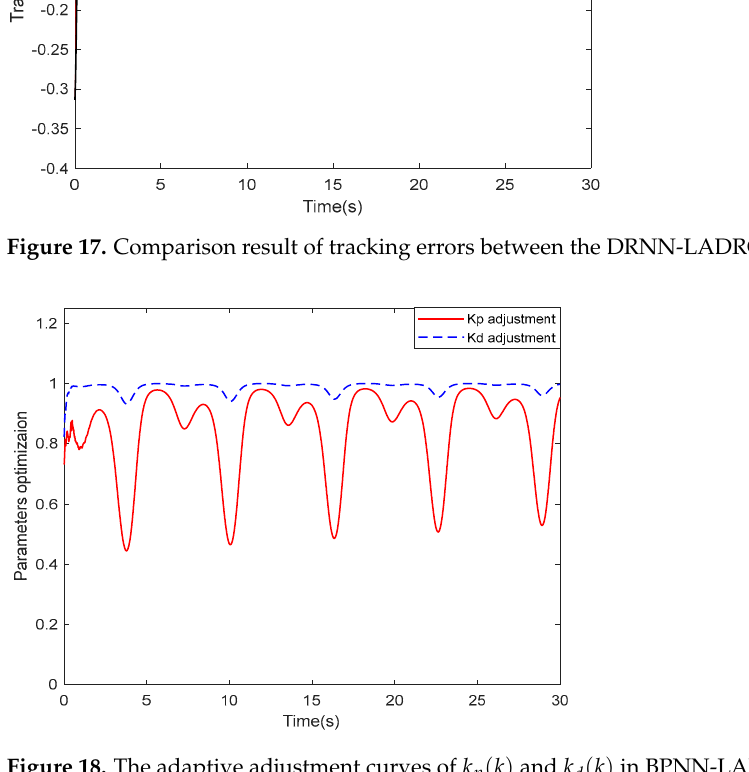
( ) k k ( ) k k and in BPNN-LADRC. d ( ) k k p ( ) k k and in BPNN-LADRC. d p